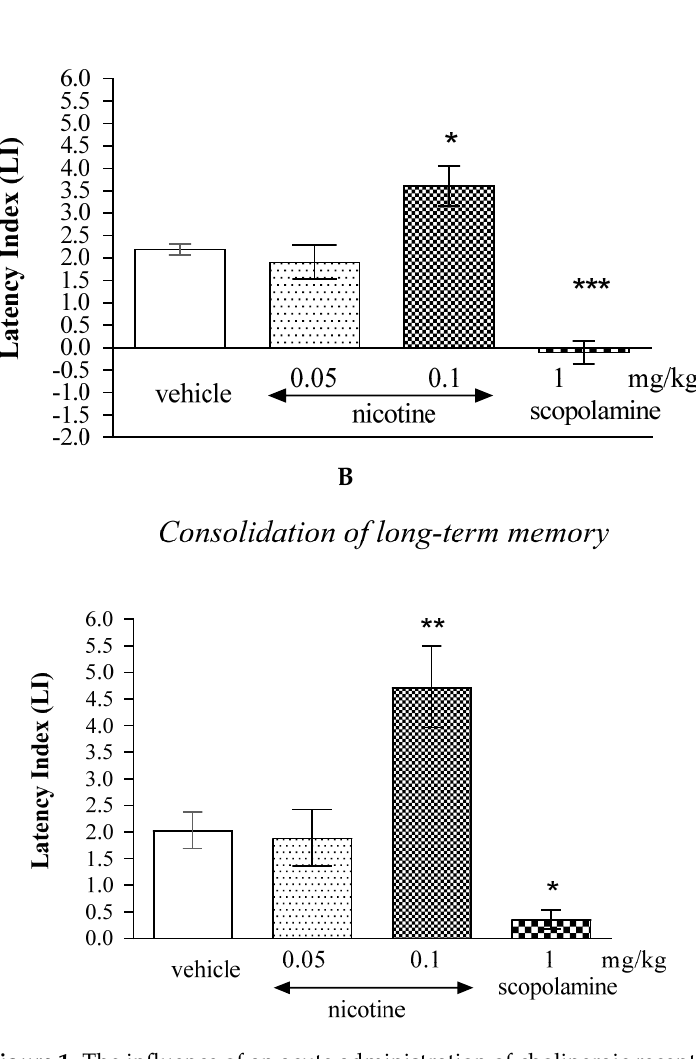
Figure 1. The influence of an acute administration of cholinergic receptor ligands on the cognition ‐ related responses, expressed as latency index (LI), during the acquisition ( A ) or consolidation of memory using the PA test in mice ( B ). Nicotine (0.05 or 0.1 mg/kg), scopolamine (1 mg/kg) or vehicle were administered 30 min before the first trial (acquisition of memory) or immediately after the first trial (consolidation of memory). The second trial was conducted 24 h after the first one; n = 8–10; the means ± SEM; * p < 0.05; ** p < 0.01; *** p < 0.001 vs. vehicle ‐ treated group; Tukey’s test.